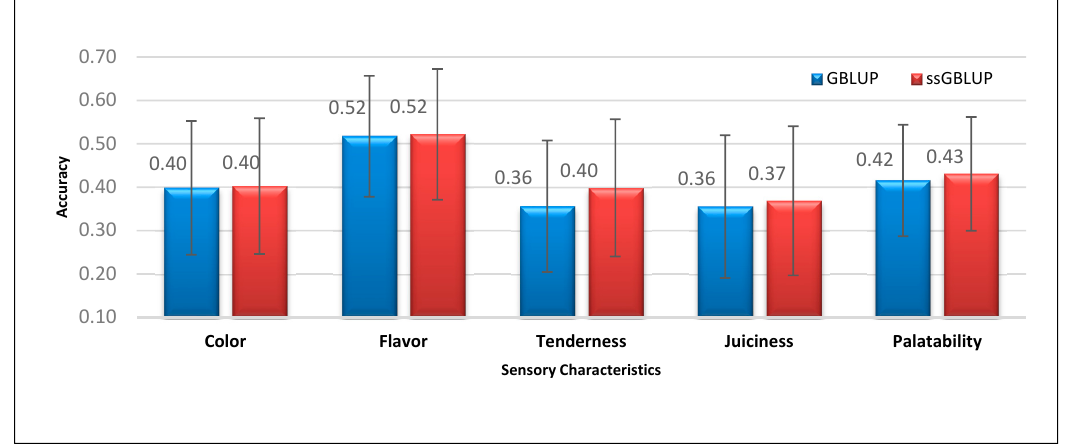
Figure 2. Prediction accuracies and standard errors obtained using GBLUP and ssGBLUP for sensory traits, including color, flavor, tenderness, juiciness, and palatability.